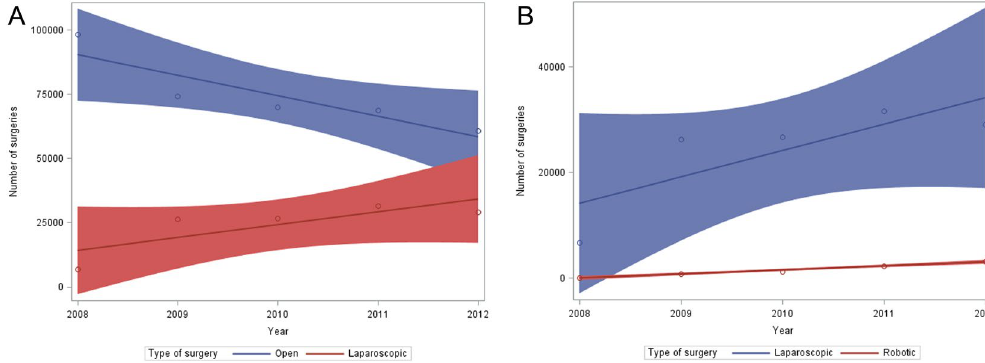
Figure 2. The number of colorectal surgeries, according to the type of surgeries, from 2008 to 2012. ( A ) Trends in the number of open vs. laparoscopic surgery ( B ) Trend in the number of laparoscopic vs robotic surgery. Circle represents the number of surgeries in a given year, the straight line is a linear regression on all the data points, and the shaded area represents the 95% confidence limits for the linear regression.